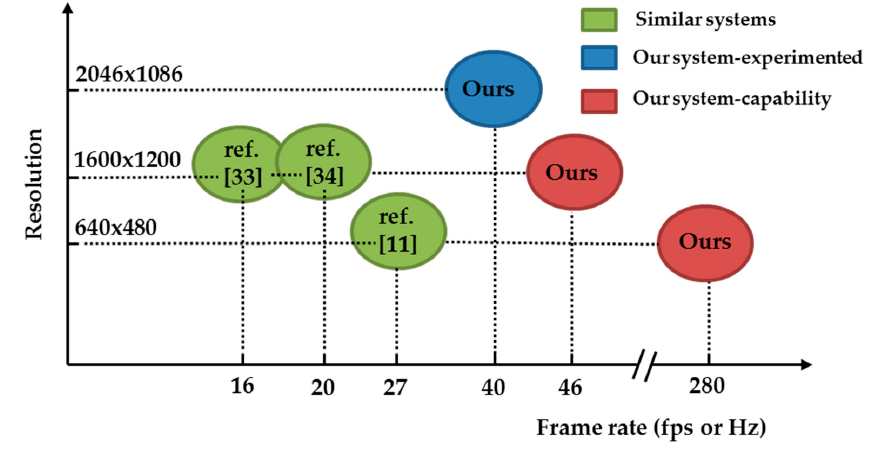
Figure 11. The system performance. fps: frames per second.